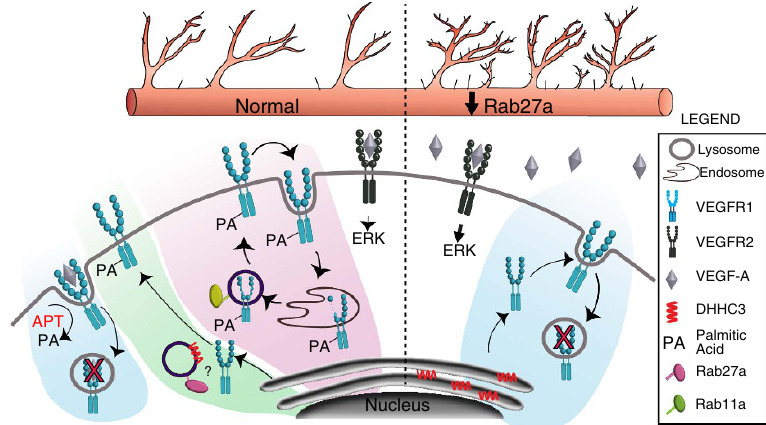
Figure 9 | Model for regulation of mVEGFR1 stability in endothelial cells. mVEGFR1 is normally (left) highly stable and slowly recycled to and from the surface via Rab11a, requiring Rab27a and DHHC3 for palmitoylation; reduced Rab27a levels (right) destabilize mVEGFR1 via reduced palmitoylation, leading to increased signalling through